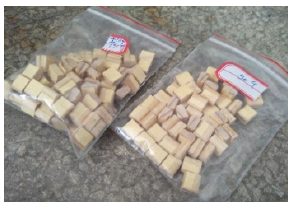
Figure 5. Taps of DCFJ312 airfoil model.